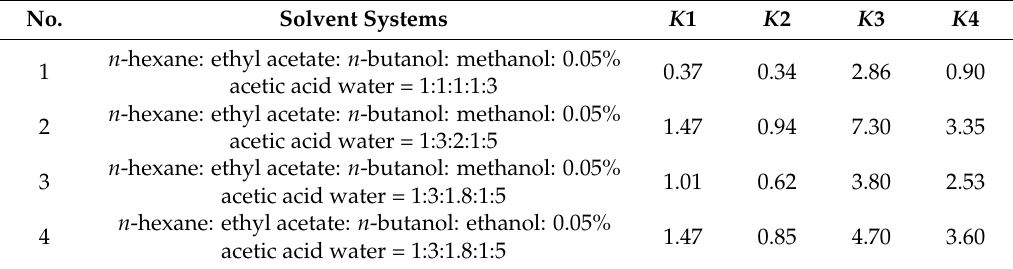
Table 2. K -values of the compounds in different two-phase solvent systems of the first-step high-speed counter-current chromatography (HSCCC)